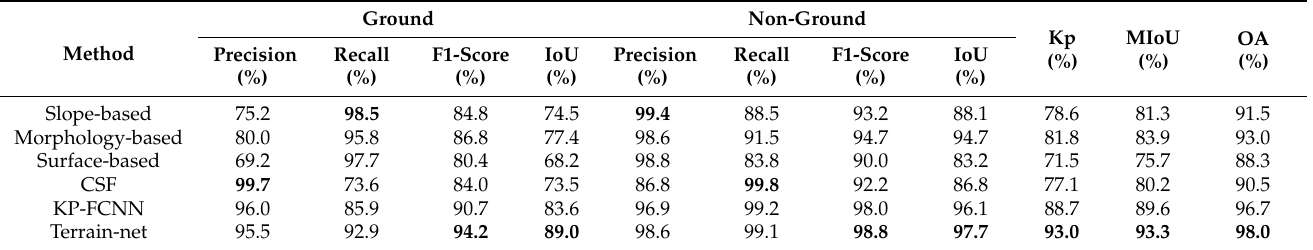
Table 2. Ground filtering results compared to traditional and deep learning algorithms on the test dataset.